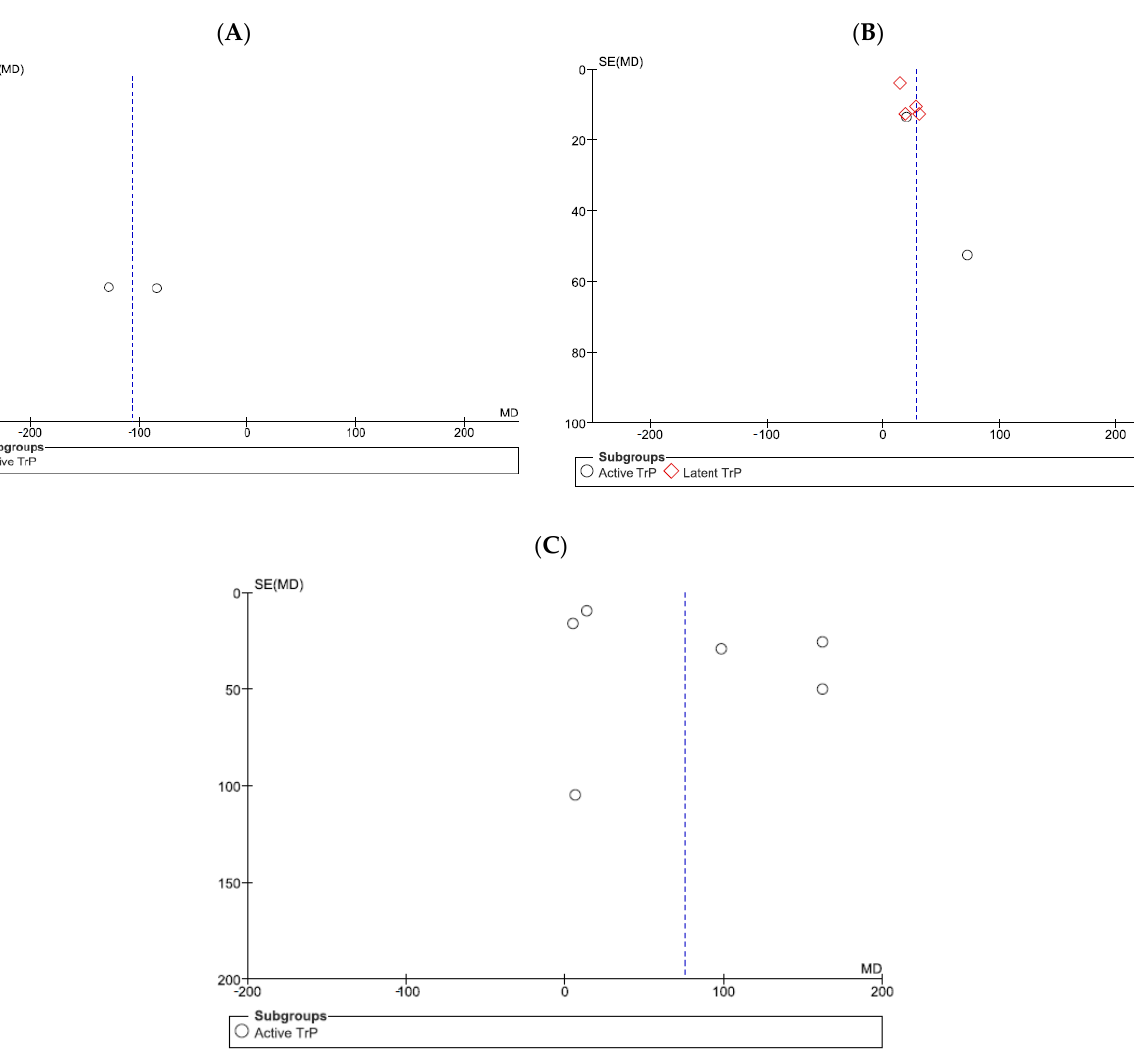
Figure 6. Funnel plot for the comparison between ( A ) patients with active TrPs and healthy controls, ( B ) manual treatment and minimal active intervention, and ( C ) physical therapy modalities and minimal active treatment.